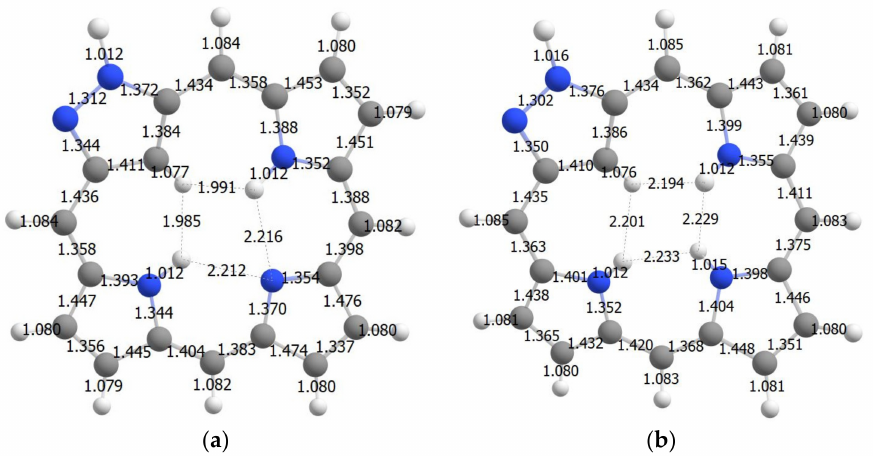
Figure 7. Calculated bond lengths and interatomic distances for the core atoms for pyrazoloporphyrin